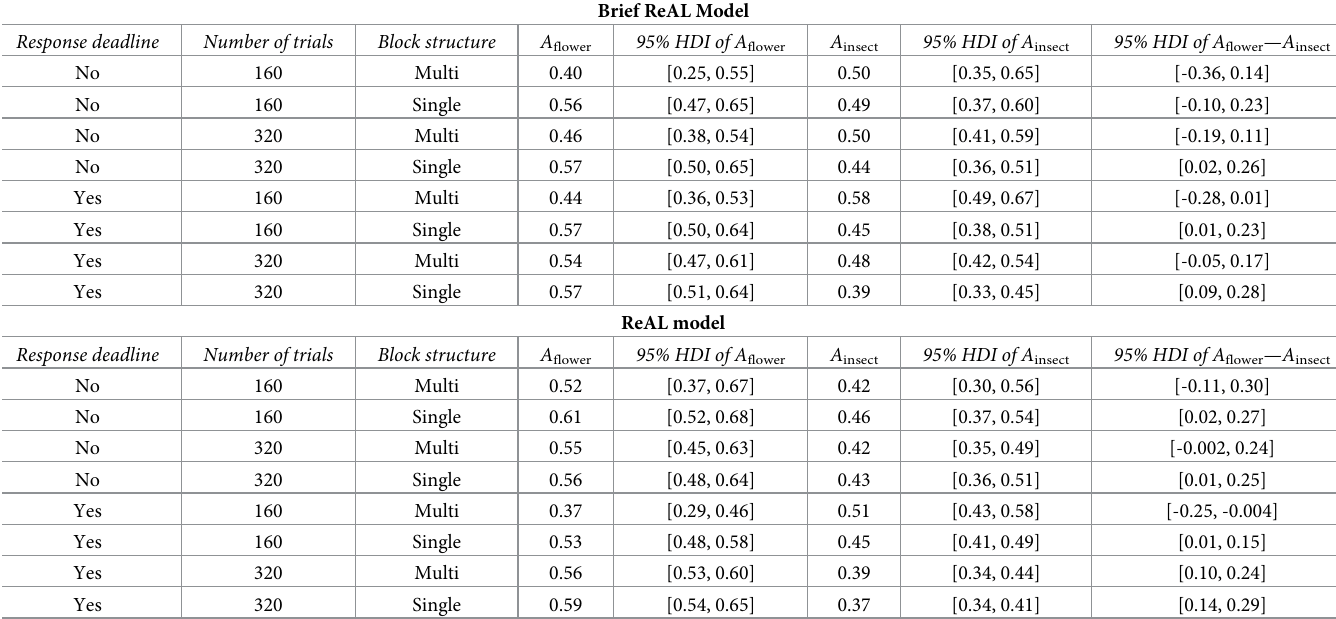
Table 8. Mean A parameter estimates and 95% HDIs of planned